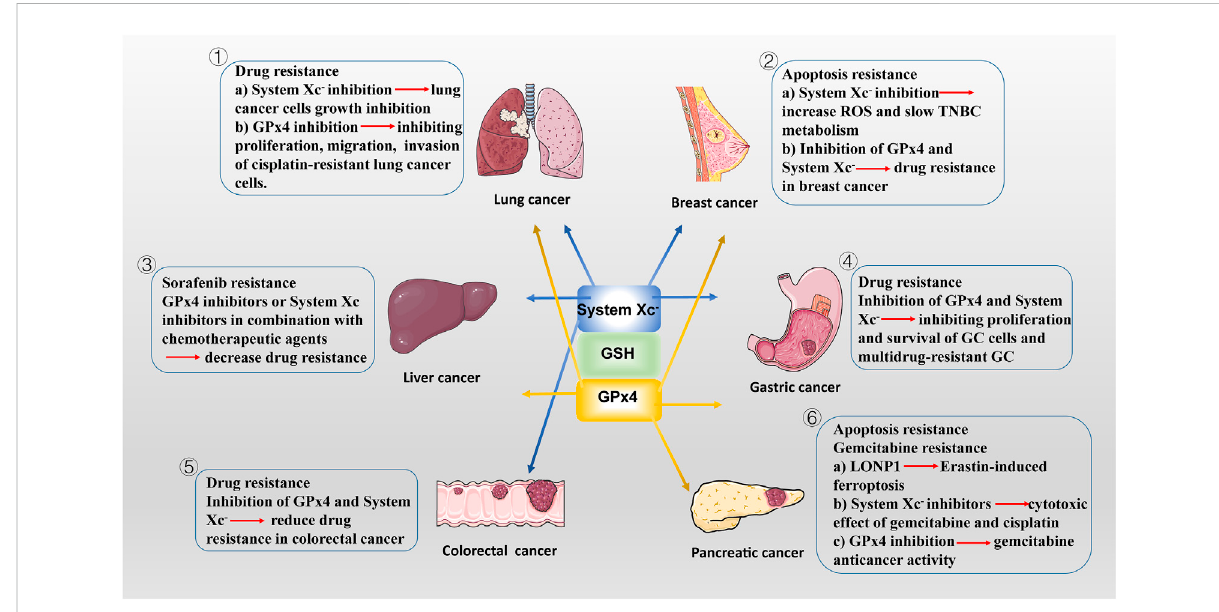
FIGURE 2 The potencial roles of System Xc-/GSH/GPx4 in drug-resistant solid tumor. ① SLC7A11, highly expressed in NSCLC, is a potential target for ferroptosis. SLC7A11 downregulation lead to ferroptosis of lung cancer cells and inhibit their growth. In addition to SLC7A11, lung cancer cell also exhibits high GPx4 expression. GPX4 inhibitor limits proliferation, migration, and invasion of cisplatin-resistant lung cancer cells. ② Drug-resistant breast cancer cells are dependent on GPX4 and SLC7A11. SLC7A11 is upregulated in one-third of TNBC cells in vivo , and inhibiting System Xc- activity increases intracellular ROS levels and slows TNBC metabolism. Inhibition of GPX4 and/or System Xc-may be a potential measure to overcomedrugresistanceinbreastcancer. ③ ThemainregulatorymediatorsmediatingtheferroptoticresponseinHCCcellshavebeenidenti fi